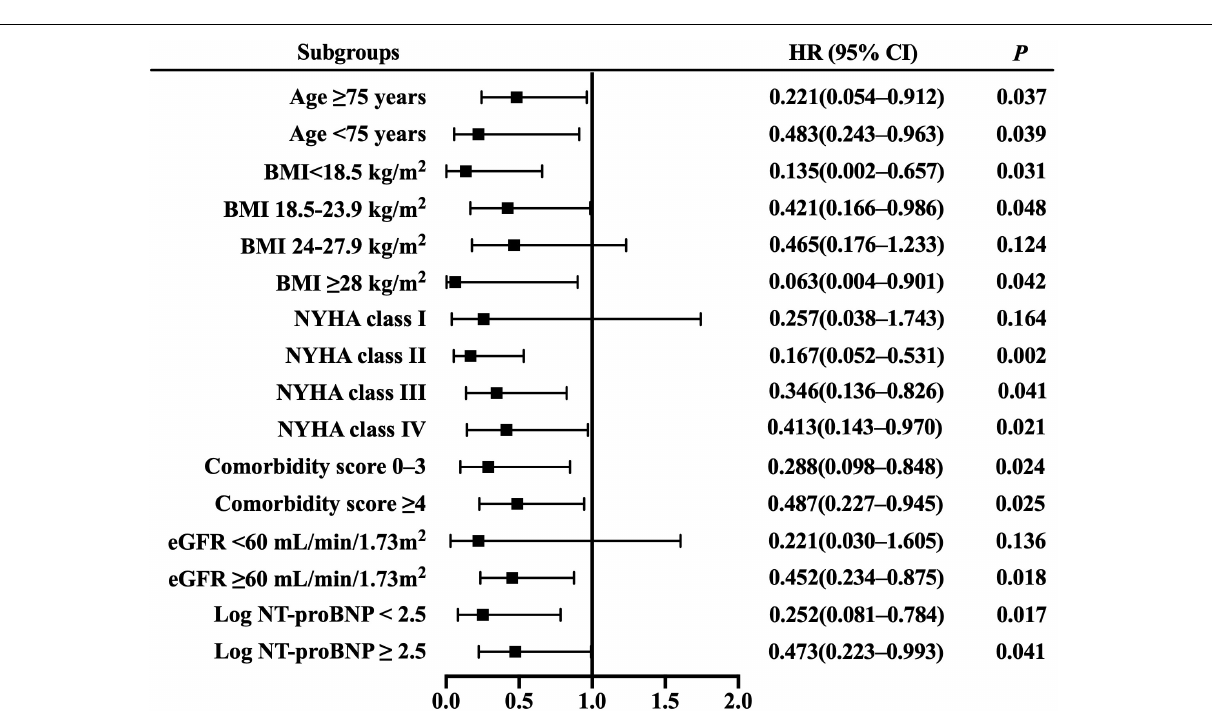
FIGURE 4 | Resting cardiac power/mass for the prediction of heart failure hospitalization: subgroup analysis. The prognostic value of resting cardiac power/mass is considered in several patient subgroups, after adjustment for age, gender, BMI, NYHA class, LVEF, comorbidity score, eGFR, log NT-proBNP, ACEI/ARB, beta blocker, and aldosterone antagonist. Other abbreviations as in Table 1